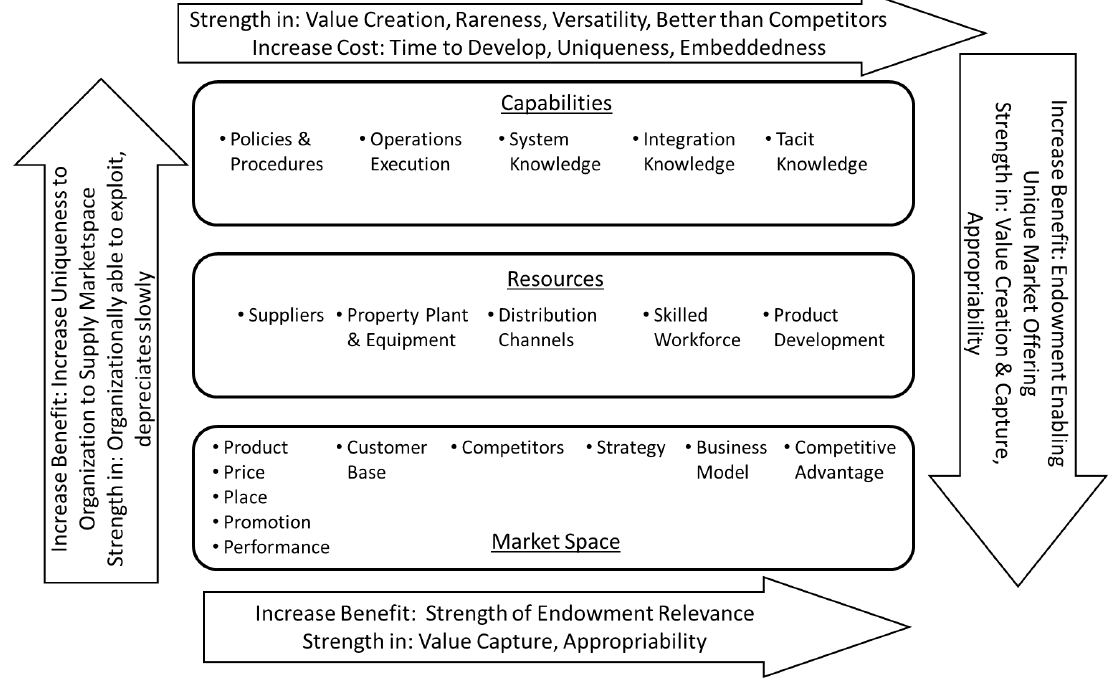
Figure 1. Innovation/ Endowment Effect Framework: Endowments of Organizations to Provide a Unique Offering to a